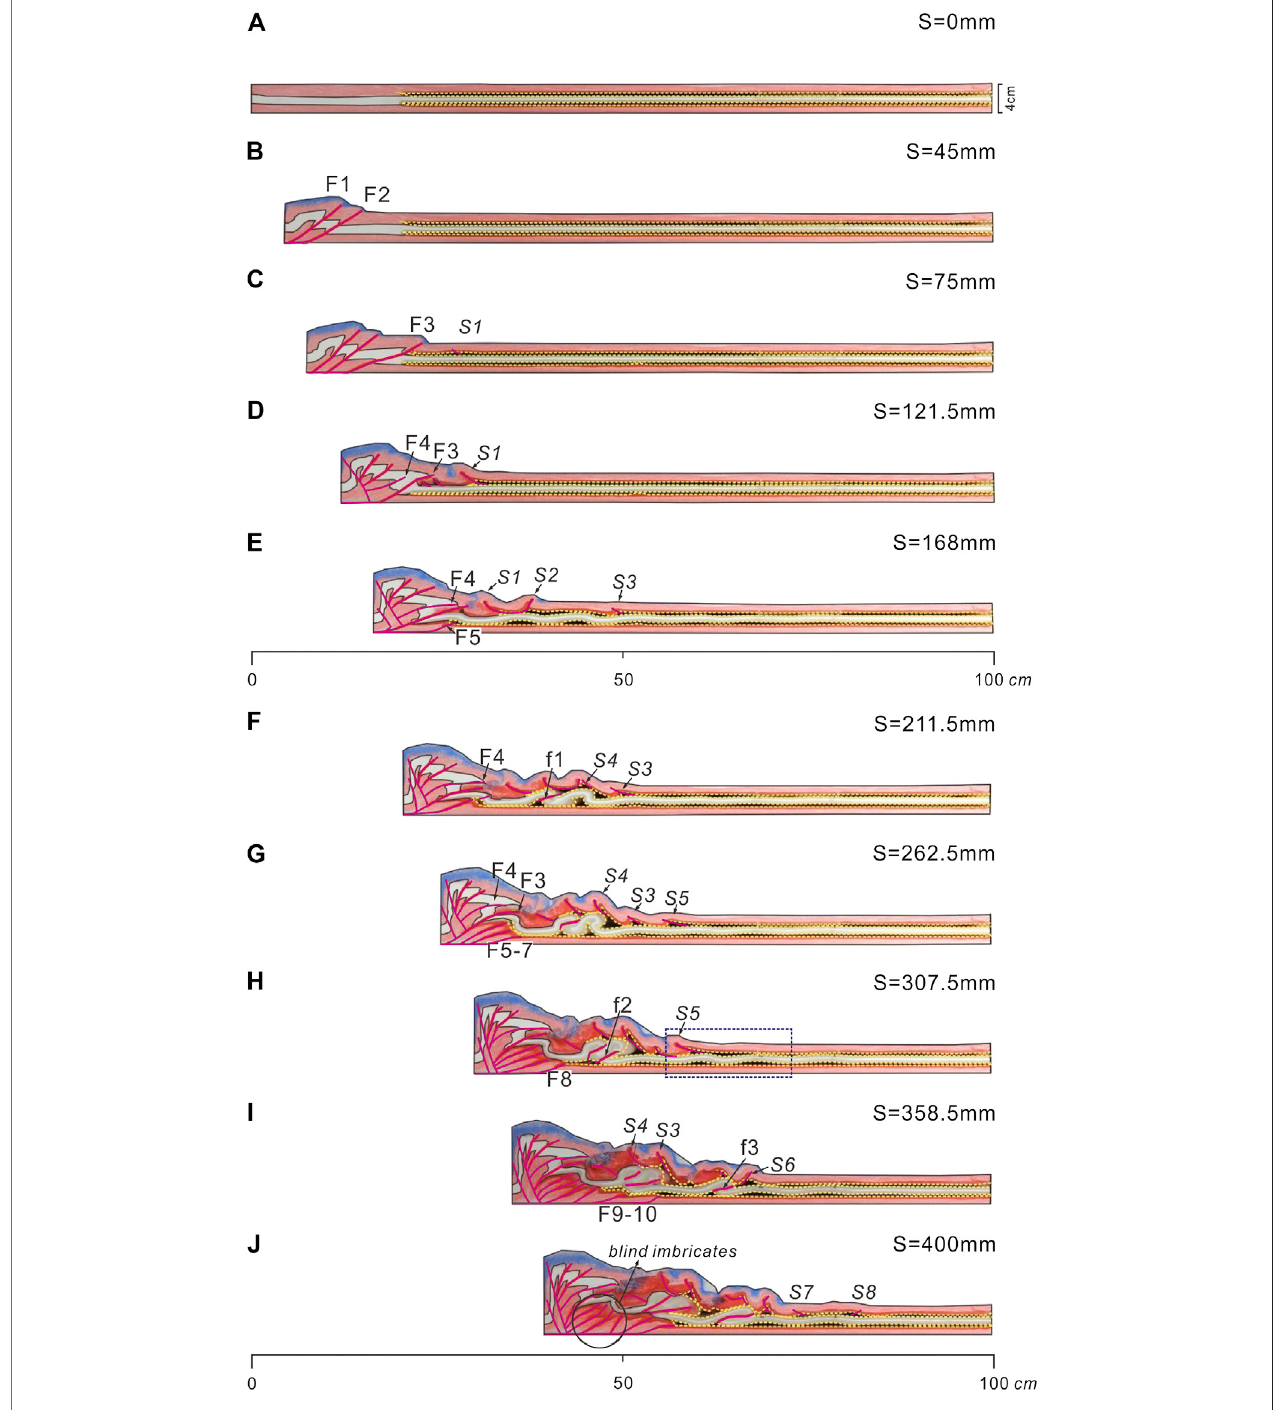
FIGURE7| EvolutionarystagesofExp.M3thatincludesaviscousMD(markedbyyellowdash line,thesame astheSDabove).Uppercase lettersSandFindicate Folds involving the shallow structural level (above the SD) only and thrusts nucleated from the basal décollement. Lowercase letter f is used to label faults limited in the middle level (between SD and MD). (A – C) Thrust stacking stages before SD in the foreland were involved by shortening; (D – J) Layered deformation within the foreland multiple décollements system. Notably, the mid-level folding affected most of the foreland area very quickly, from (D) to (E) with ∼ 45 mm of shortening. This fast deformation propagation toward the foreland controlled the styles of successive deformation in both the shallow and deep levels. See the text for details.